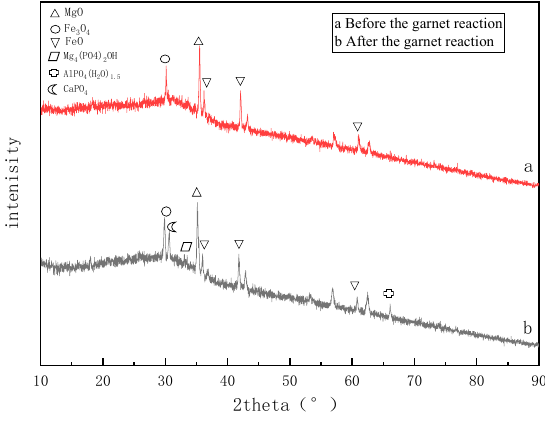
Figure 13. Magnesia XRD results.